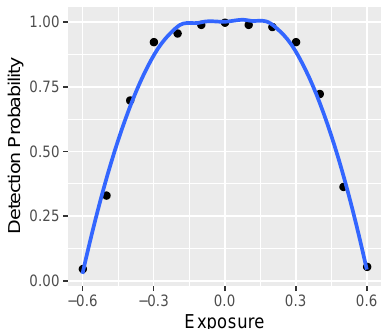
Figure 6. Face recognition detection [probability] for exposure [eq